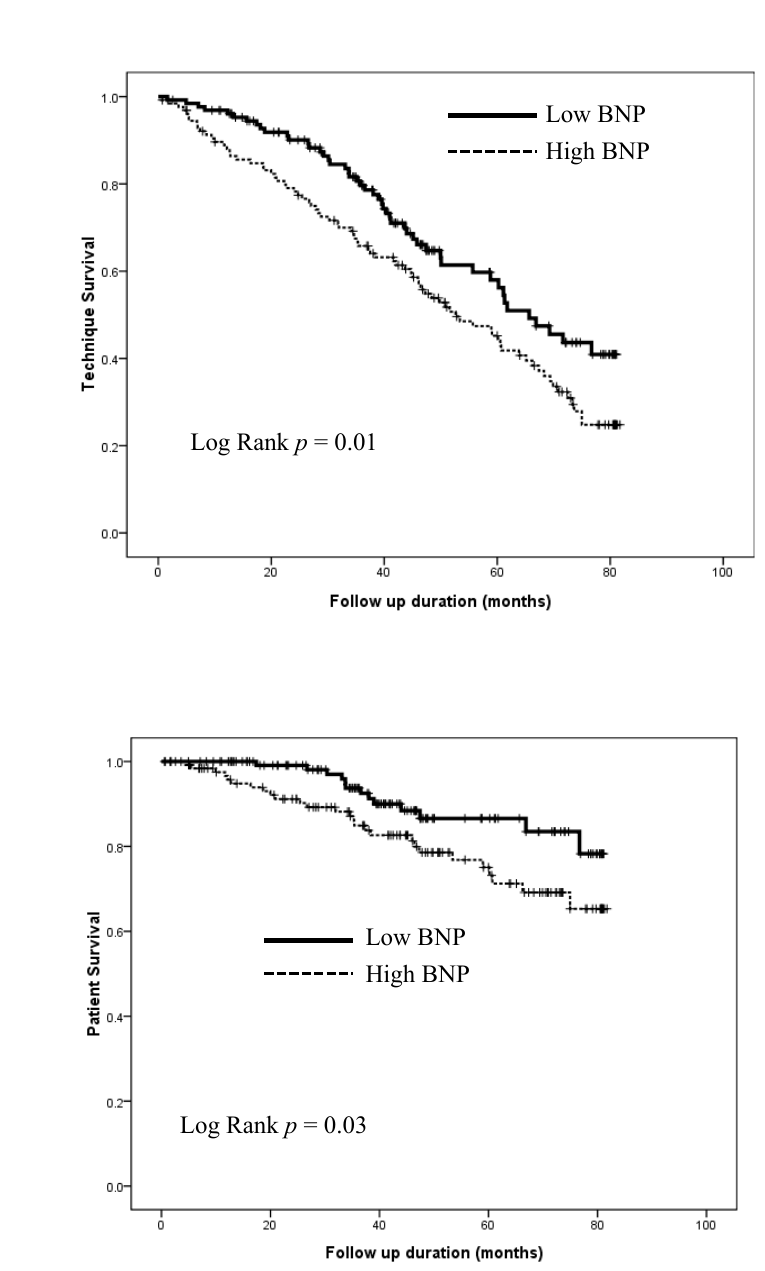
Figure 3. Kaplan–Meier based technique survival curves ( A ) and overall survival curves ( B ) of PD patients with high or low NT-proBNP levels at baseline. BNP, brain-type natriuretic peptide; PD, peritoneal dialysis.